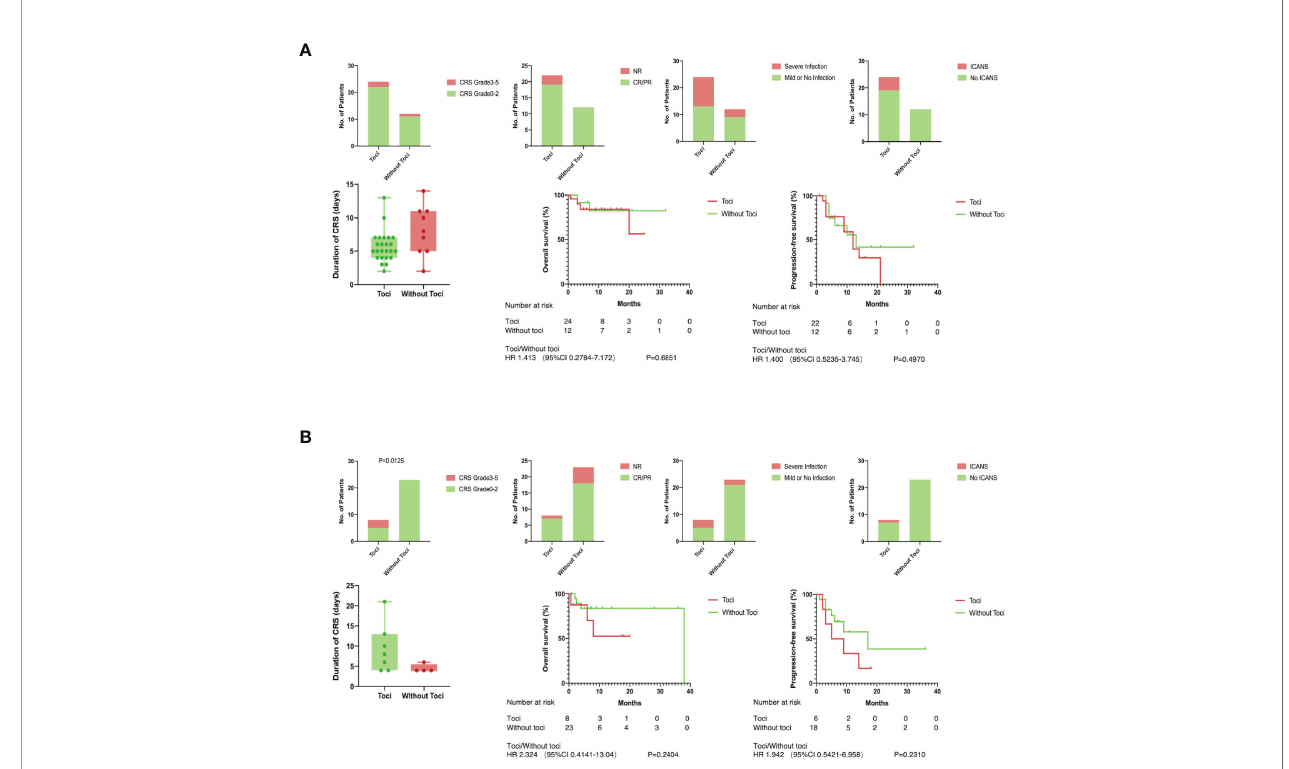
FIGURE 4 | Tocilizumab induced severe CRS in low level group. There was no signi fi cantly difference between patients with toci and without toci except for one. (A) Duration of CRS, incidence of severe infection and ICANS, objective response rate in short-term, overall survival and progression-free survival in long term were compared between patients with or without toci in high level group of IL-6; (B) Duration of CRS, incidence of severe infection and ICANS, objective response rate in short-term, overall survival, and progression-free survival in the long term were compared between patients with or without toci in low level group of